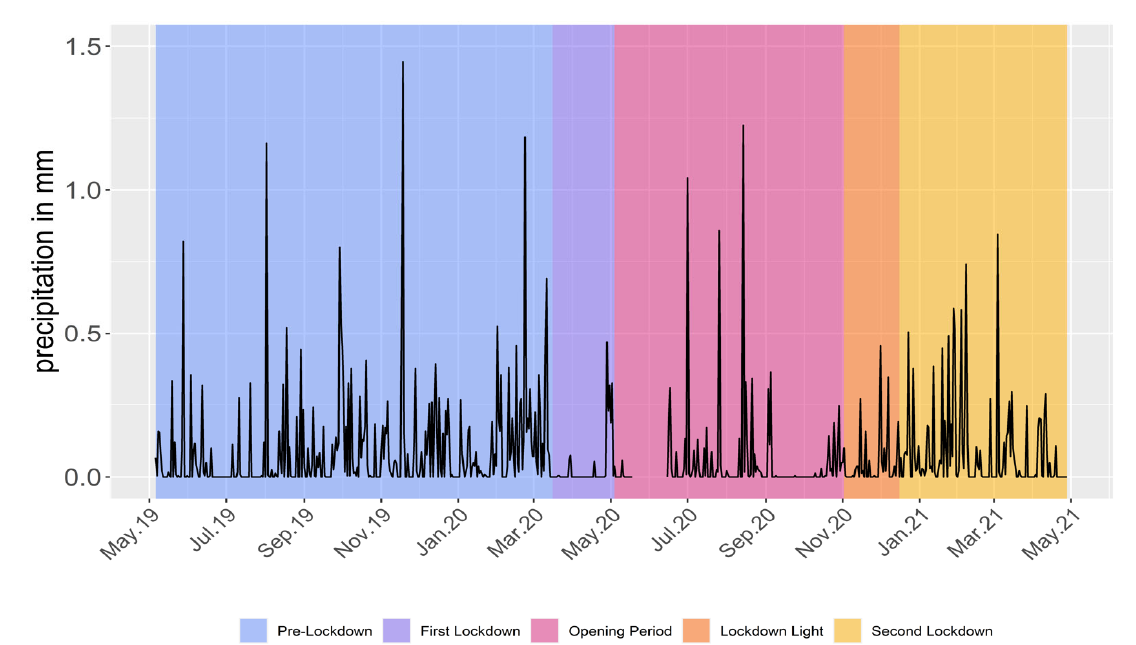
Figure A4. Daily means for precipitation in mm over time. The missing parts from mid-May to mid-June 2020 are attributed to the SALVE devices not being in the field because of maintenance. For consistency, the precipitation data are also not depicted in this timeframe.